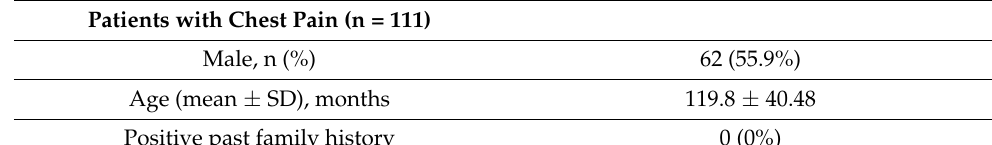
Table 1. Patient demographics and clinical